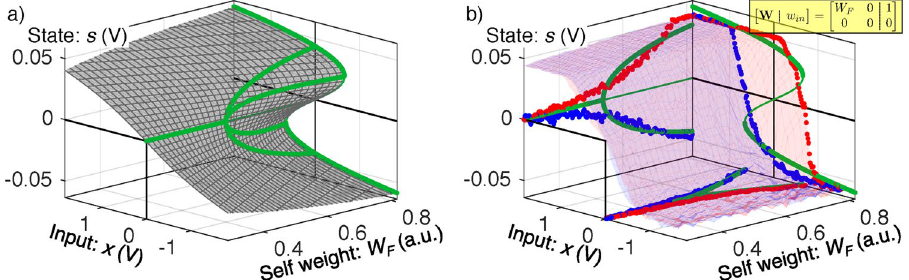
Figure 2. A cusp bifurcation in a single node with feedback weight, W F , external input, u , and neurosynaptic state, s . ( a ) Theoretical model surface (gray) and bifurcation curves (green) plotted in 3D. Parameters of the model are fit to data. ( b ) Experimental data for increasing (blue surface) and decreasing (red surface) input. Theoretical bifurcation curves – with parameters identical to those in ( a ) – are projected onto 2D axes. The data surfaces are sliced at the planes: u = 0, s = 0, and W F = 0.08, and similarly projected onto the axes (red and blue points) to illustrate the reproduction of pitchfork, cusp, and saddle-node bifurcations,